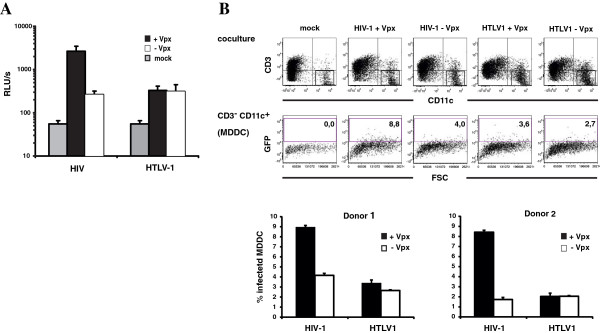
Vpx does not enhance HTLV-1 transmission to MDM or MDDC. (A) Jurkat cells were cotransfected with an antisense-intron-containing HTLV-1 or HIV-1 luciferase reporter plasmid, the respective packaging plasmid and pVSV-G. After 24 h, the transfected Jurkat cells were cocultured at a ratio of 2:1 with MDM that had been preincubated for 2 h with 25 ng p27 of Vpx-containing (+Vpx) or control VLP (−Vpx). After 48 h, the Jurkat cells were removed and adherent MDM were lysed and the luciferase activity was determined in quadruplicates. Background luciferase activity was determined by transfection of Jurkat cells with control plasmids (mock). The data are expressed as relative light units (RLU). One of four independent experiments is shown. (B) Jurkat cells were cotransfected with HTLV-1 or HIV-1 GFP reporter plasmids, the respective packaging plasmid and pVSV-G. After 24 h, the transfected Jurkat cells were cocultured at a ratio of 2:1 with MDDC that had been pretreated with 25 ng p27 of Vpx-containing (+Vpx) or control VLP (−Vpx). After 48 h, the cells were analyzed by flow cytometry to detect transmission of HIV-1 GFP and HTLV-1 GFP from the Jurkat cells to the MDDC by staining with anti-CD3-PECy5 to detect the Jurkat cells and anti-CD11c-APC to detect the MDDC. The infected MDDC were defined as the CD3-/CD11c + population. The data are the average of triplicate infections with error bars to indicate the standard deviation. One of three independent experiments is shown.